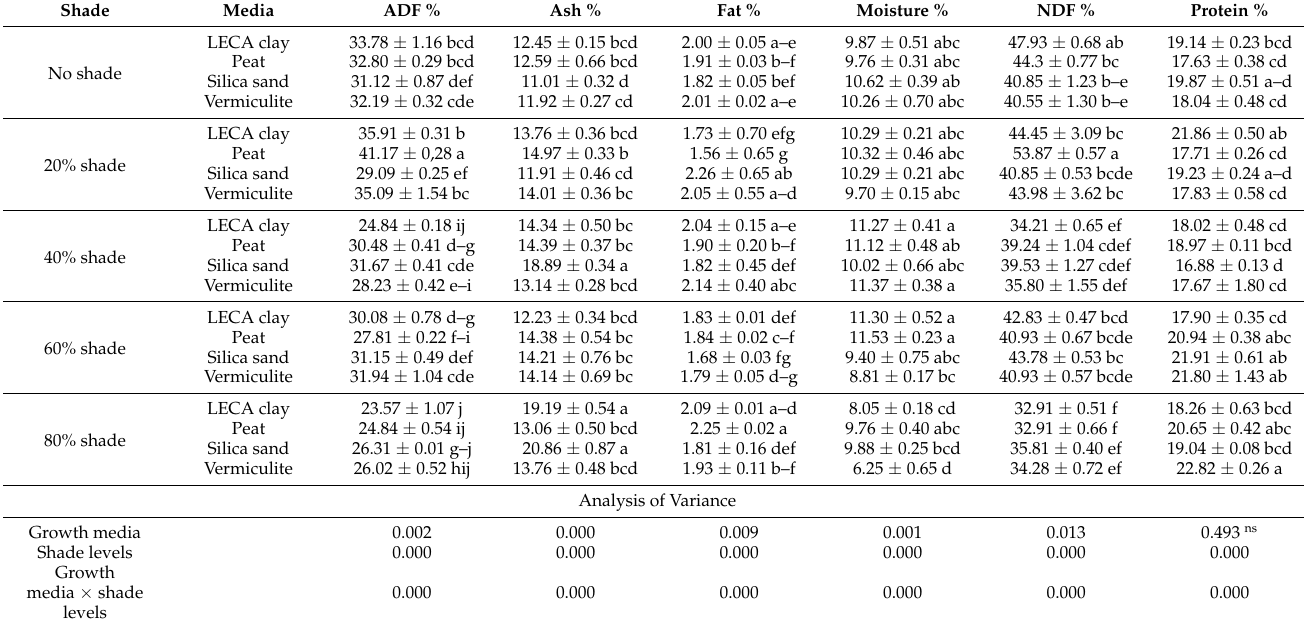
Table 5. The effect of different growth media and shade levels on proximate analysis in the flower buds of T. divaricata